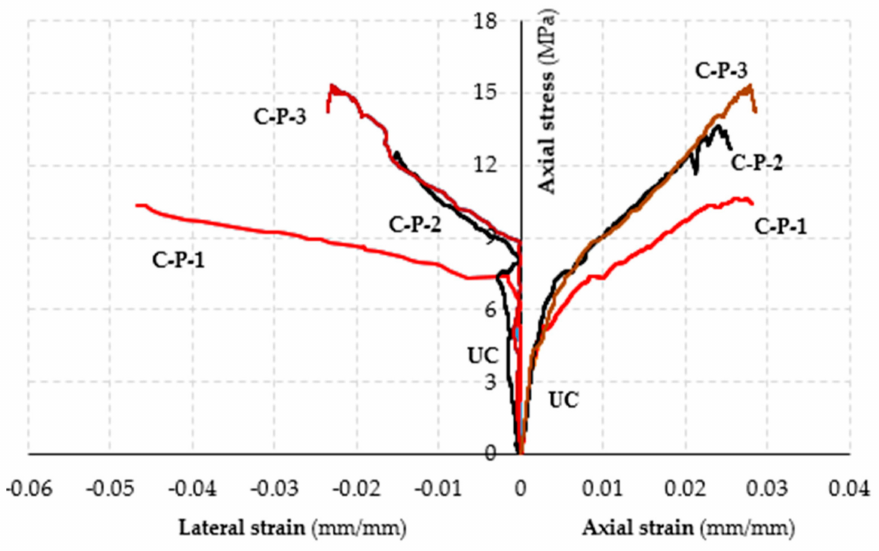
Figure 14. Axial stress-strain curves for PBO-FRCM confined